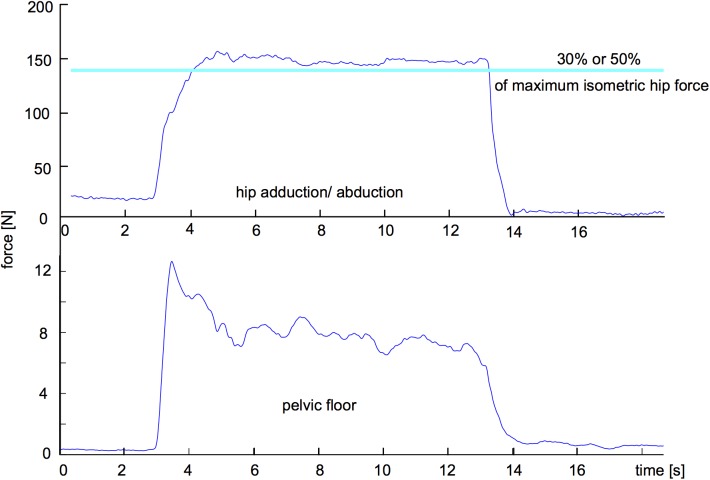
Example of visual feedback during data acquisition: time series of force data from the thigh dynamometer (above graph) and the target level of 30% of hip isometric force; time series of force data from the vaginal dynamometer (bellow graph).